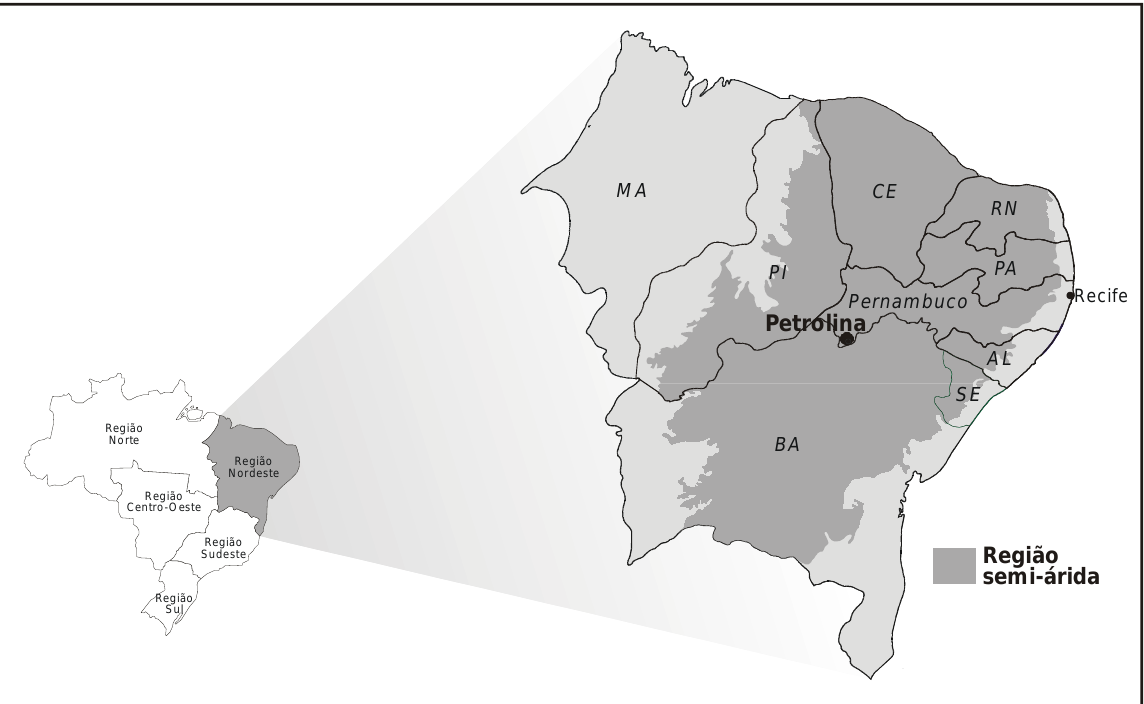
Figura 1. Região Nordeste do Brasil, incluindo o local de estudo no semi-árido do estado de Pernambuco.